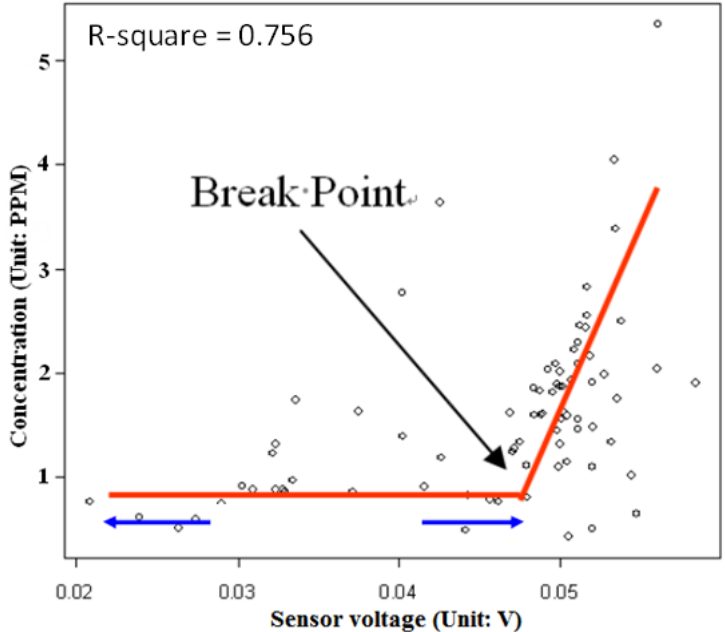
Figure 5. Segmented regression was employed to transfer the voltage of the sensor to the concentration of carbon monoxide. Every sensor has its own regression